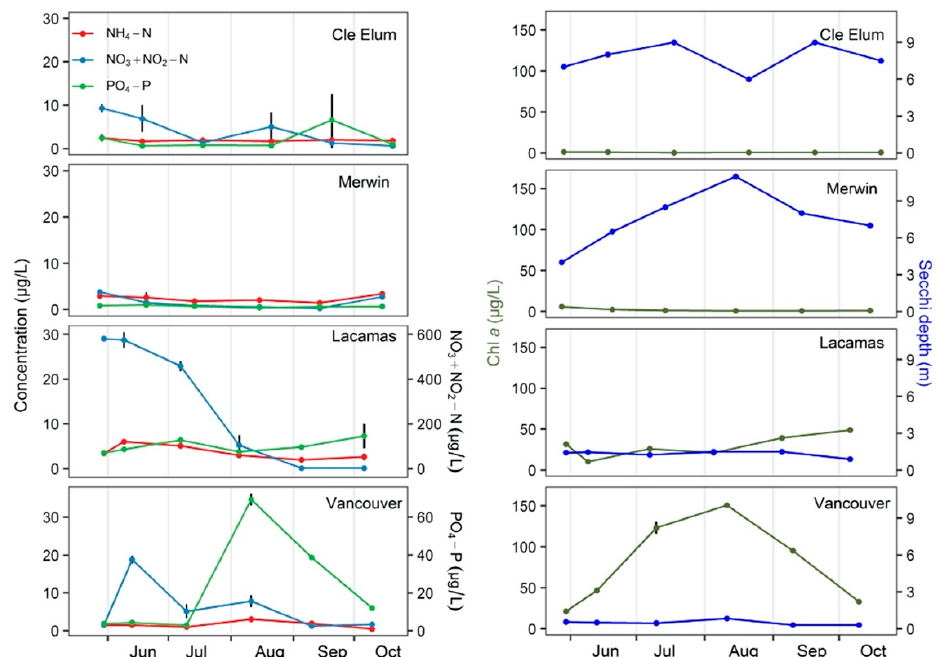
Figure 3. Monthly concentrations of NH 4 -N, NO 3 +NO 2 -N, and PO 4 -P ( µ g/L) in left panels, and chlorophyll a ( µ g L − 1 ) and Secchi disk depth (m; secondary y-axes) in right panels, measured in Cle Elum, Merwin, Lacamas, and Vancouver lakes from May through October 2014. Note that NO 3 +NO 2 -N and PO 4 -P are shown separately on the secondary y -axis only for Lacamas and Vancouver lakes, respectively.